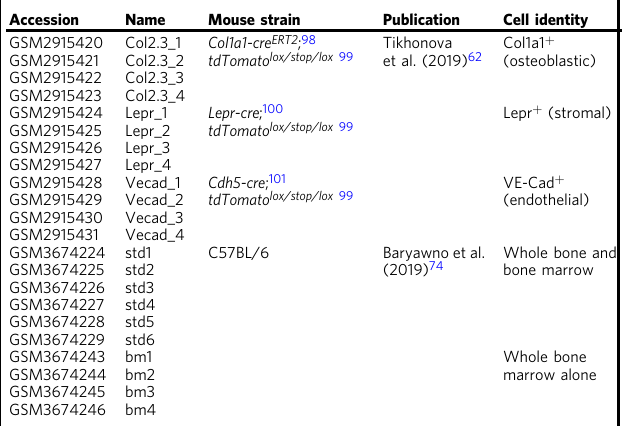
Table 1 Fluorophore-conjugated antibodies used in endothelial cell isolation and peripheral blood phenotyping FACS experiments.